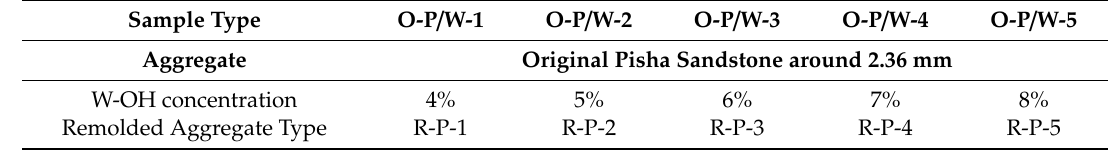
Figure 2. Demonstration of the raw materials for sample synthesis. ( a ) The original W-OH polyurethane primer under oil state; ( b ) tap water to initiate the polymerization process; ( c ) the generated polyurethane polymer; ( d ) the as-received Pisha sandstone aggregate; ( e ) the remolded Pisha sandstone particles with remained polyurethane on the surface. Table 1. Preparation of the Pisha sandstone composites with original polyurethane.